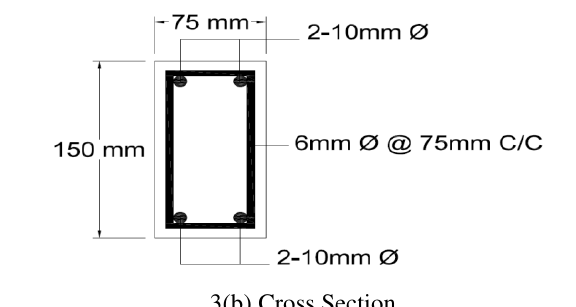
Fig.3: Reinforcement detail of test specimen